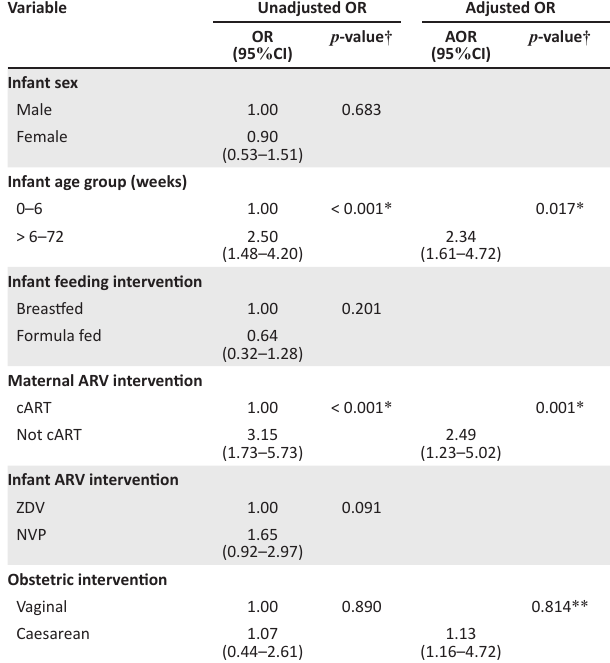
TABLE 2: Multivariable logistic regression of predictors of HIV transmission among HIV-exposed infants